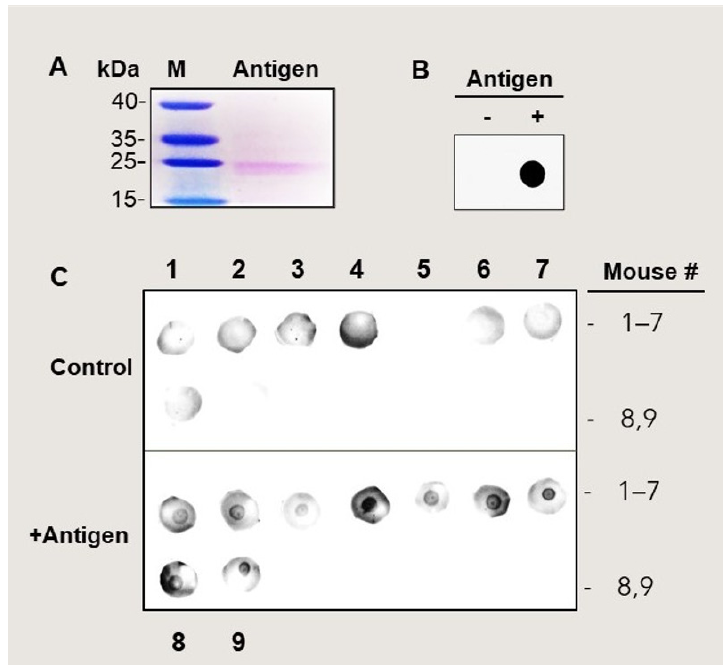
Figure 2. Antigen-injected mice produce antibody against MetO-rich protein in blood-plasma. ( A ). The MetO-rich protein (Antigen) was produced and purified according to the procedures described under the “Materials and Methods” section. The purified antigen was separated on SDS-gel-electrophoresis that was stained with Coomassie brilliant blue (the limited protein staining level is due to the relatively low presence of basic amino acids in the Met-rich protein sequence). M, molecular mass markers; kDa, molecular mass numbers. ( B ). A dot-blot analysis using the MetO-rich protein as the loaded protein (Antigen) and rabbit anti-MetO antibody (1:1000 dilution) as the primary antibody. ( C ). A dot-blot analysis using the MetO-rich protein, as the loaded protein (Antigen), probed with plasma moiety (used as the primary antibody, 1:100 dilution, 1 h incubation time) from 10-month-old mice. Only the antigen-injected mice showed positive reactions with the antigen (a round black reaction in the middle of the blot), while the controls were all negative. Numbers 5 and 9 of the control blots had almost no background